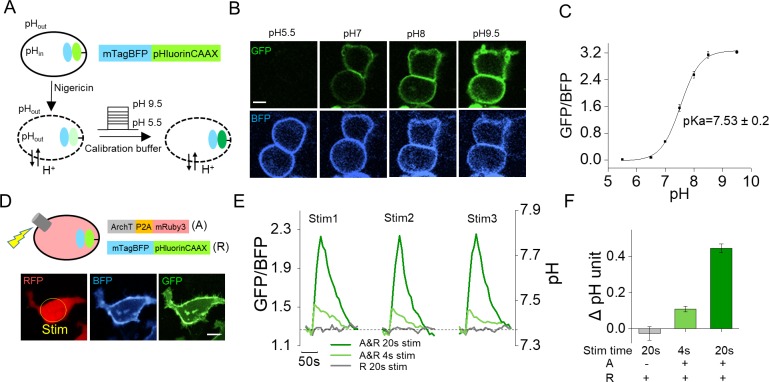
Quantification of ArchT activation-induced pH change in actuator cells.(A) Schematic diagram showing the process for calibrating pH. (B) Confocal images showing pHluorin (top) and BFP fluorescence (bottom) of cells perfused with buffers with the indicated pH levels. (C) pH calibration curve for mTagBFP-pHluorinCAAX. The GFP/BFP ratio was fitted with a Hill function (n = 10 cells for each point). (D) Schematic diagram and confocal images showing co-expression of mTagBFP-pHluorinCAAX and ArchT-P2A-mRuby3. The yellow circle indicates the stimulation region. (E) Representative traces of the GFP/BFP ratio and pH change upon a 20 s or 4 s stimulation at 561 nm (three stimuli delivered at 3-min intervals) in cells co-expressing mTagBFP-pHluorinCAAX and ArchT-P2A-mRuby3 (green lines) and in cells expressing only mTagBFP-pHluorinCAAX (gray line). Error bars indicate the s.e.m. from triplicate experiments. (F) Summary of the estimated peak change in pH in the experiments shown in (E) based on the calibration curve shown in (C) (n = 10 cells per group). The scale bars represents10 μm. A, actuator cells; R, receiver cells.